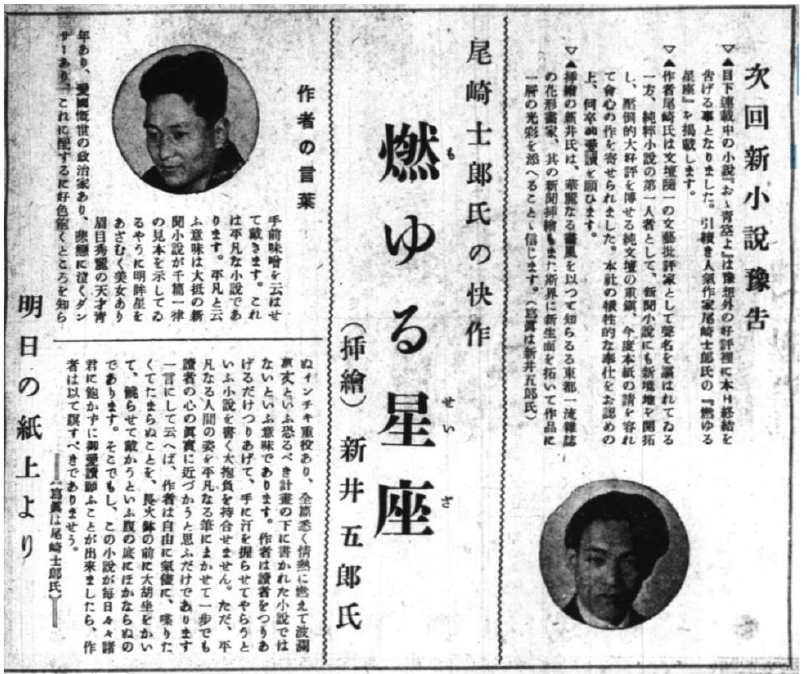
Figure 5. Preview of Constellations Ablaze . Kashū mainichi 2 November 1937. Image courtesy of the Hoji Shinbun Digital Collection.